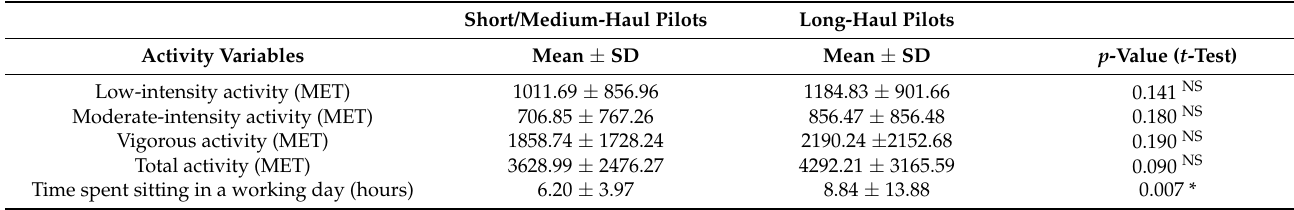
Table 3. Levels of physical activity and sedentarism according to flight type.